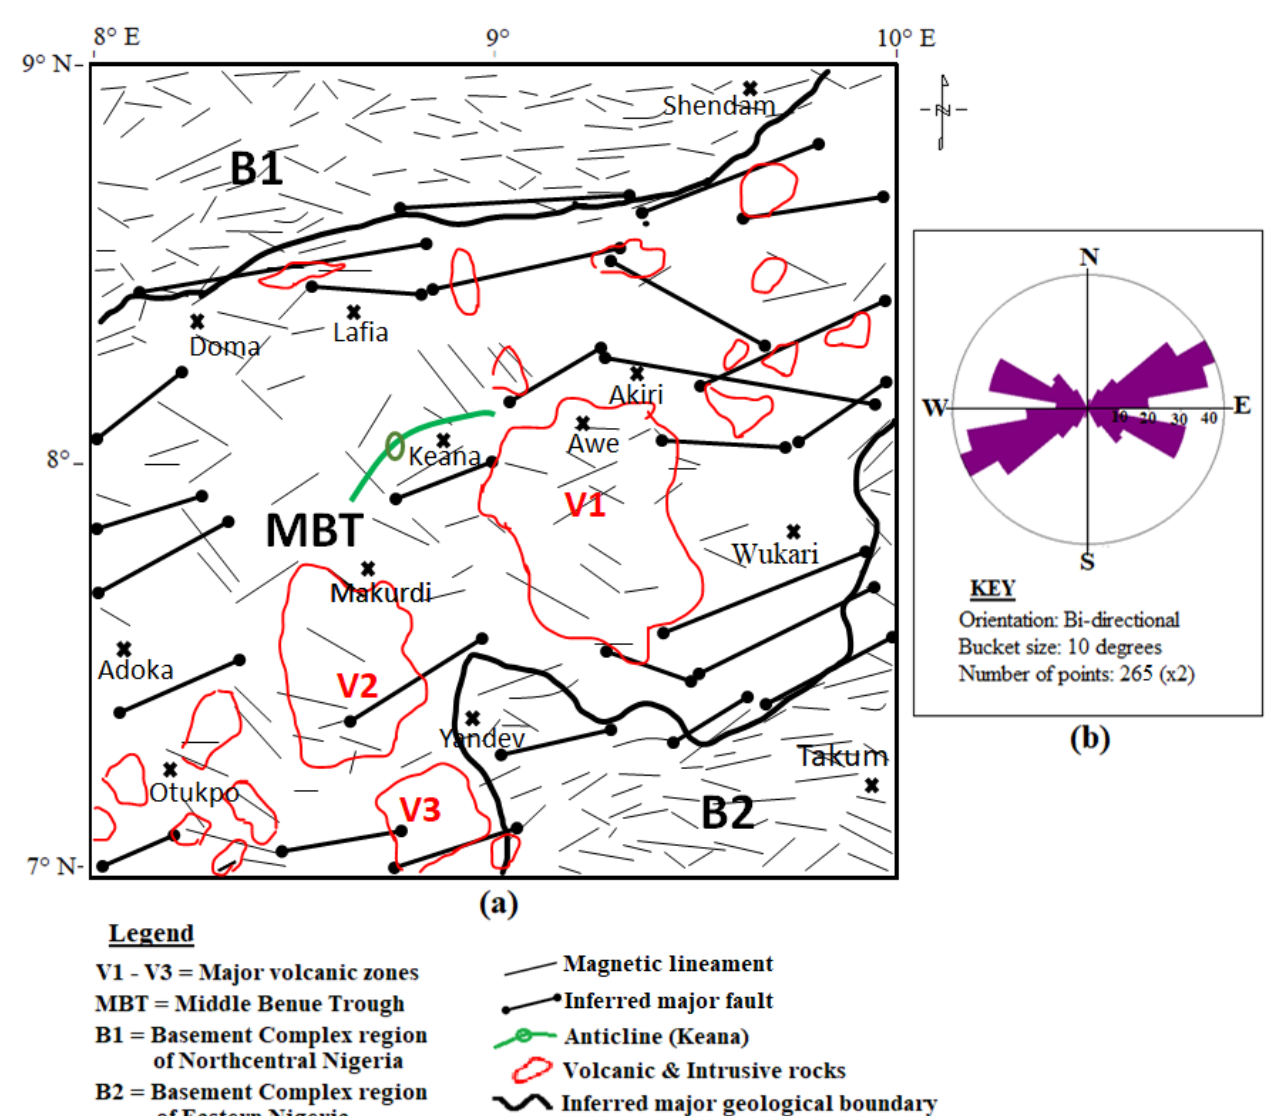
Figure 8. ( a ): Structural map obtained from magnetic derivatives of the area. ( b ): Rose diagram showing the orientation of the faults.